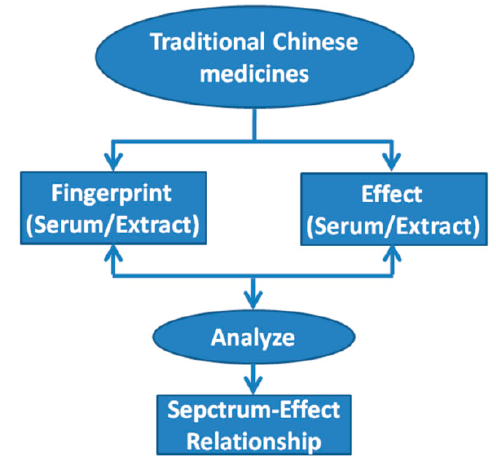
Figure 1. The spectrum-effect relationships for Traditional Chinese medicines (TCMs).